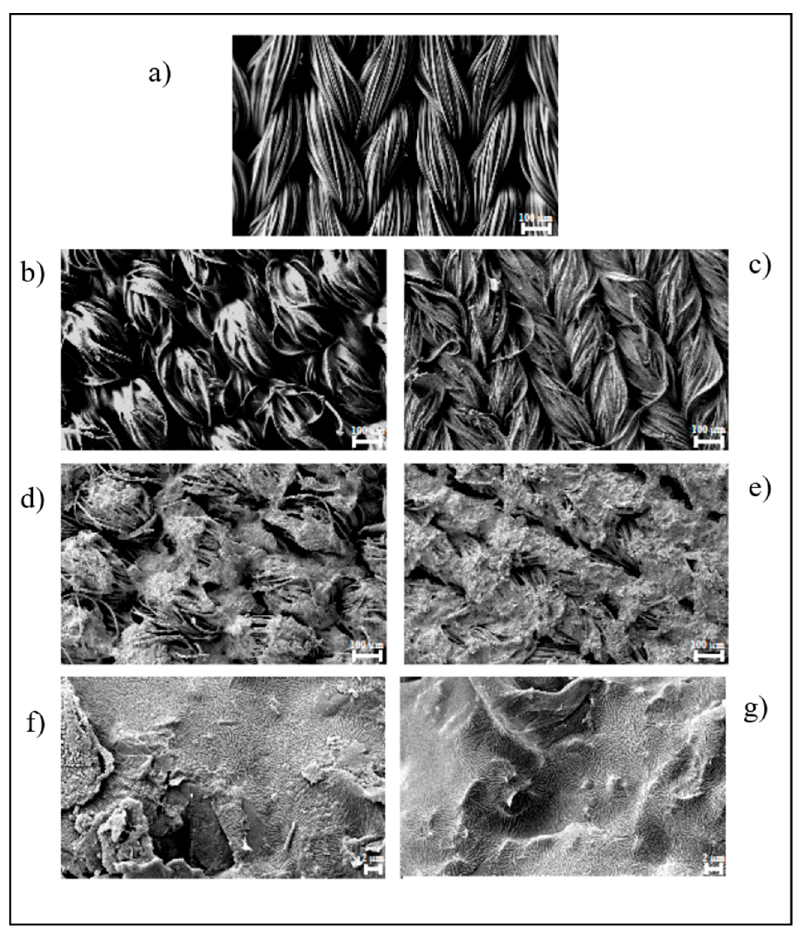
Figure 2. FESEM images of: ( a ) neutral fabric UT (Bar 100 μ m); ( b ) P1 screen printed fabric (Bar 100 μ m); ( c ) P2 screen printed fabric (Bar 100 μ m); ( d ) and ( e ) screen printed fabric with P1GNPs; ( f ) and ( g ) screen printed fabric with P2GNPs at different magnifications (Bar 100 μ m and Bar 2 μ m, respectively).